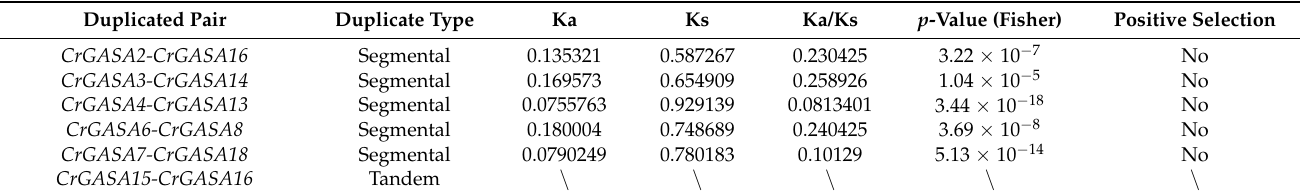
Table 2. Ka/Ks analysis and duplicated type calculation for CrGASA genes.